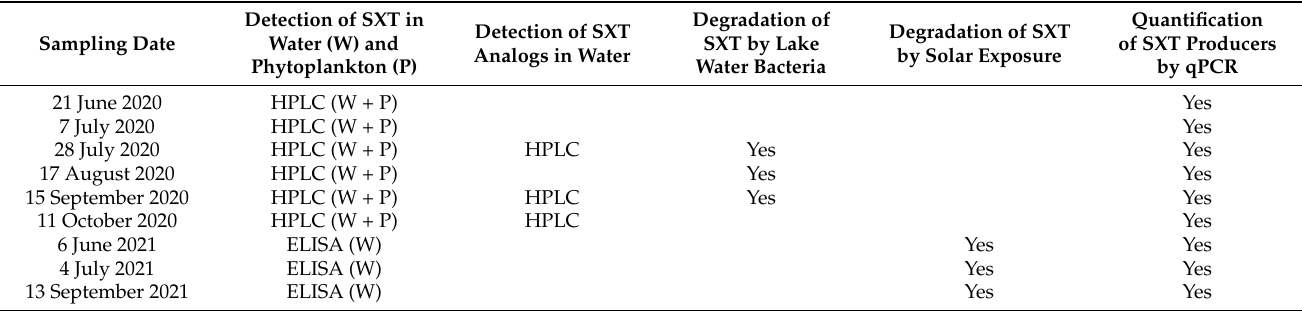
Table 1. Overview of sampling dates, analyses and treatments of Lake Arresø